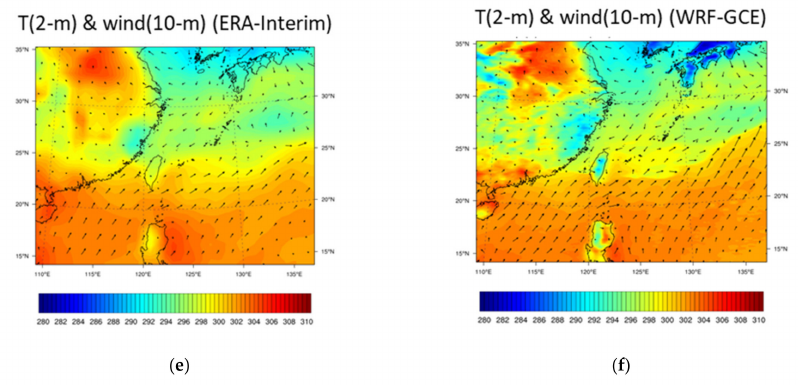
Figure 4. Weather chart of the reanalysis ( a , c , e ) and GCE ( b , d , f ) at 500 and 850 hPa and at the surface. Valid on 02 June 2017at 1200 UTC.